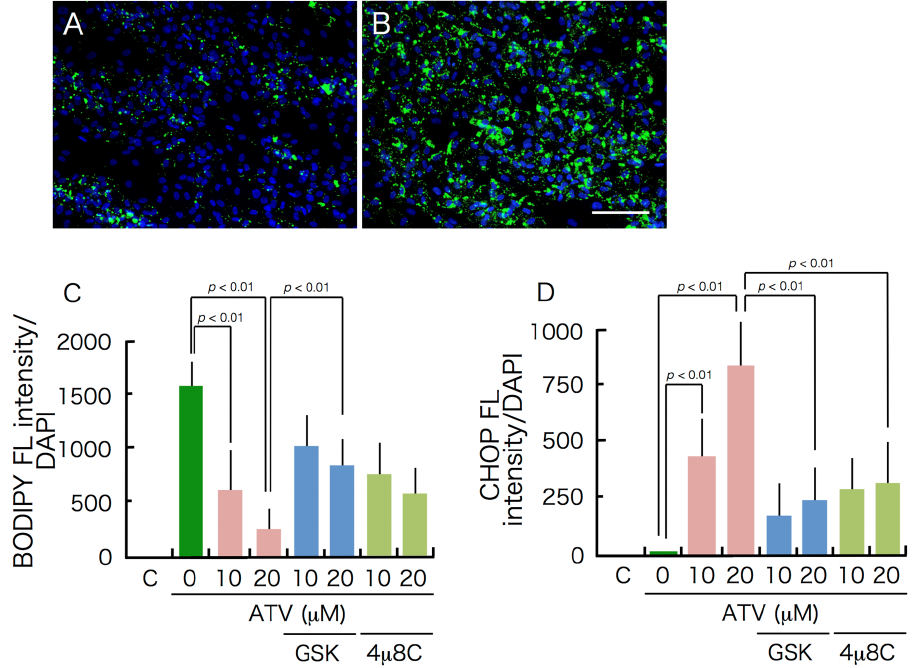
Figure 8. Effects of ER stress inhibitors on differentiation. GSK2606414 and 4 µ 8C, which inhibit